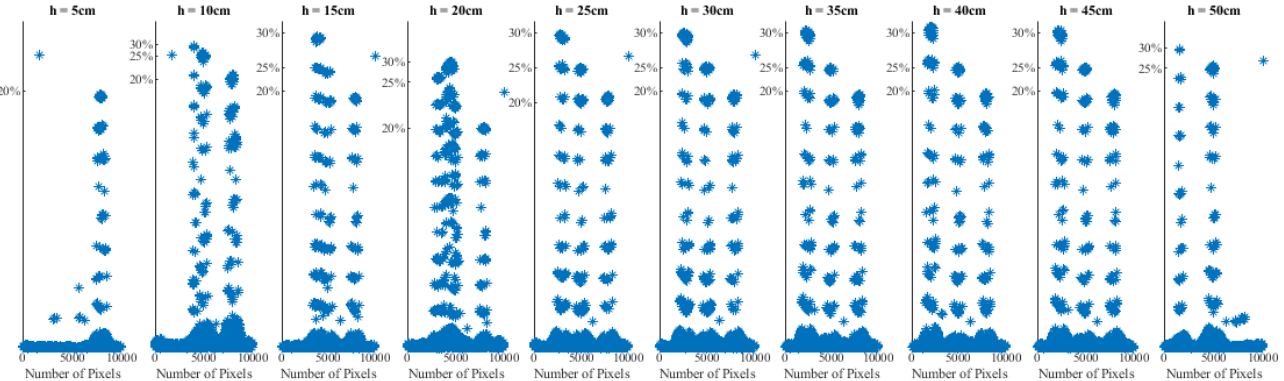
Figure 7. The locations of moisture distribution in (5 cm, 10 cm, 15 cm, 20 cm, 25 cm, 30 cm, 35 cm, 40 cm, 45 cm, and 50 cm) and predicted in high (7.5 cm, 12.5 cm, 17.5 cm, 22.5 cm, 27.5 cm, 32.5 cm, 37.5 cm, 42.5 cm and 47.5 cm).